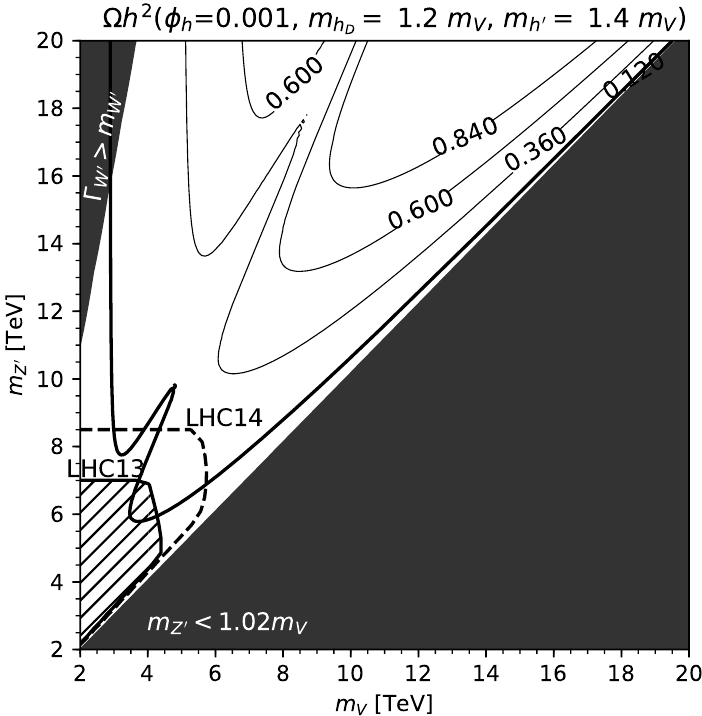
Figure 4 . The contours show the DM relic abundance as a function of the masses of the DM and Z 0 . Here, (cid:30) h = 0 : 001, m h = 1 : 2 m V and m h 0 = 1 : 4 m V . The measured value of the DM energy D density is shown by the thick-solid contour. The DM is overabundant in the region above the thick- solid contour. The region (cid:12)lled by the hatched pattern is excluded by the ATLAS experiment [42]. The prospect at the HL-LHC is also shown by the dashed curve [44]. In the larger black-shaded region, g 0 is beyond the perturbative unitarity bound, see table 2. In the black-shaded region in the left-top corner, (cid:0) W 0 > m W 0